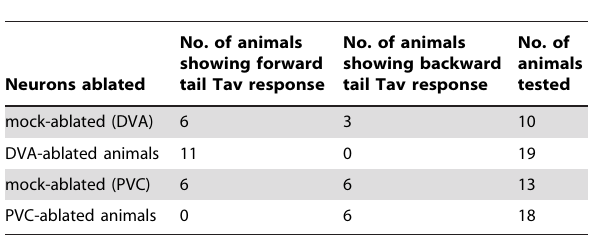
Table 1. The PVC and DVA interneurons mediate thermonociception in the tail of C. elegans